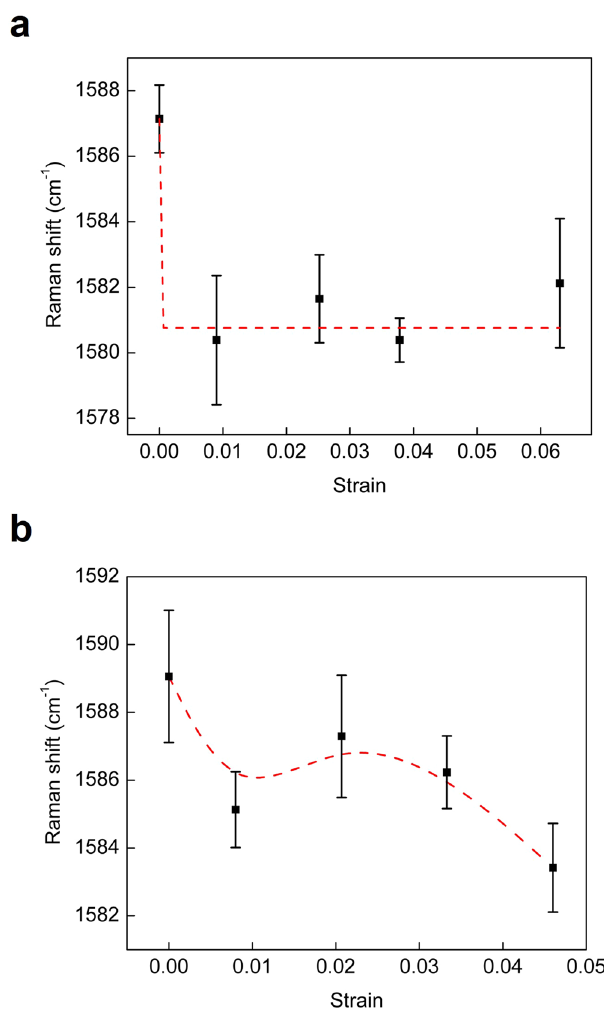
Figure 11. Shift of the G band in the Raman spectra of the CNT yarns during tensile testing as a function of strain. Diameter: ( a ) 10 μ m and ( b ) 1 μ